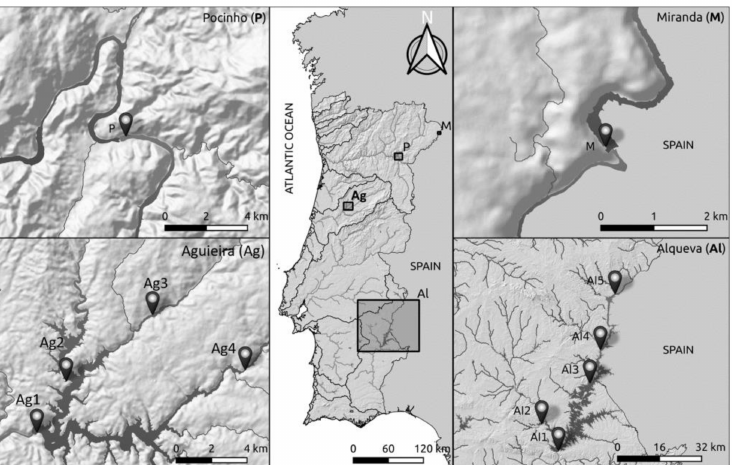
Figure 1. Map with sampling sites in the Miranda, Pocinho, Aguieira, and Alqueva reser- voirs, Portugal. M—Miranda (41 ◦ 29 (cid:48) 24.802” N, 6 ◦ 15 (cid:48) 55.925” W). P—Pocinho (41 ◦ 08 (cid:48) 10.884”